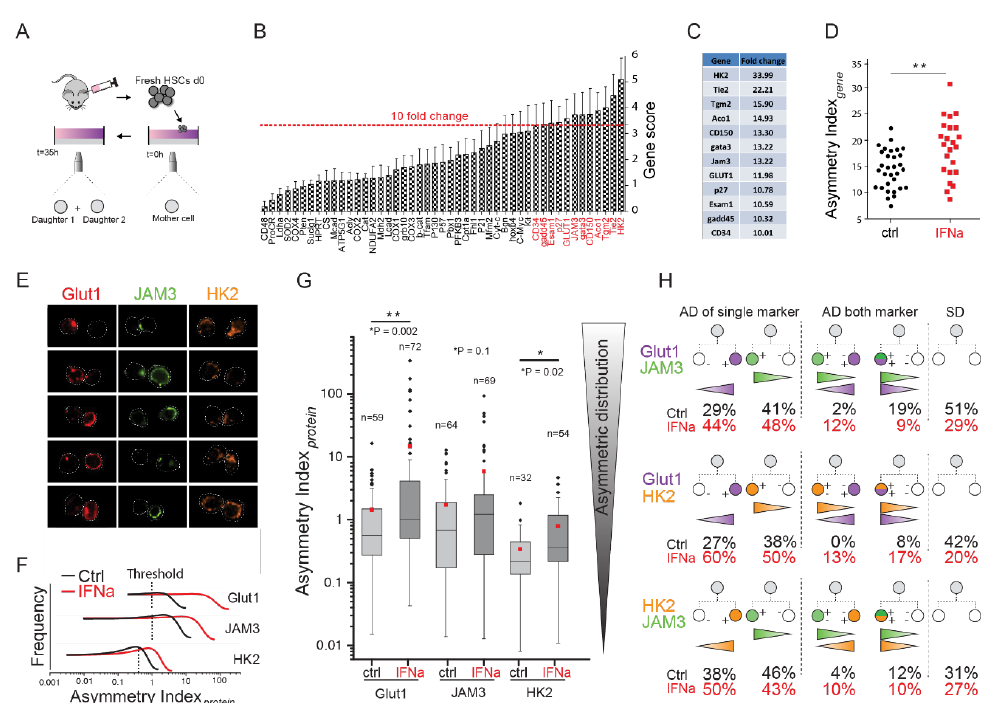
Figure 2. Identification of asymmetric gene and protein expression in paired daughter cells (PDCs). ( A ) Freshly isolated HSCs were tracked during culture until first division (35 h) using a time-lapse microscope. A microwell array platform was used for gene expression analysis and a micro-groove platform for protein expression analysis (Figure S2); ( B ) The gene score values show a wide variation from one gene to another. A stringent threshold (average 10-fold di ff erence in gene expression between PDCs) was put to identify the “asymmetric gene set”; ( C ) Table showing 12 candidate genes that were seen to cross the 10-fold threshold (fold change values in table); ( D ) IFN α -treated PDCs show a higher asymmetry index as compared with control PDCs; ( E ) Representative immunofluorescent images showing asymmetric expression of Glut1, JAM3, and HK2 in 15 di ff erent PDCs; ( F , G ) Analysis of PDCs asymmetry for Glut1 ( n = 59 control and n = 72 IFN α ), JAM3 ( n = 64 control and n = 69 IFN α treatment), and HK2 ( n = 32 control and n = 54 IFN α ) with IFN α -treated cells or control; ( F ) PDCs asymmetry in frequency with threshold defining “asymmetric protein expression” used in ( H ) Glut1 = 1, JAM3 = 1, HK2 = 0.3; ( G ) PDCs asymmetry. IFN α condition shows significantly higher levels of asymmetric index for Glut1 and HK2 as compared with the control. Boxplot’s interquartile range from the 25th to the 75th percentile. A line and red square show, respectively, median and mean, and the error bar is SD (outliers lower or upper inner fence is equal to 1.5 the interquartile range); ( H ) The protein expression pattern in PDCs (all PDCs considered) for Glut1, JAM3 and HK2. Asymmetry with one marker (first column) are shown in total percentage (without considering other markers). A double asymmetry (two asymmetric proteins) analysis is shown in the second column. An asymmetry comprising two proteins (for example “P1” and “P2”) on two daughter cells (defined by c a and c b ) is either “coinciding”, a cell having